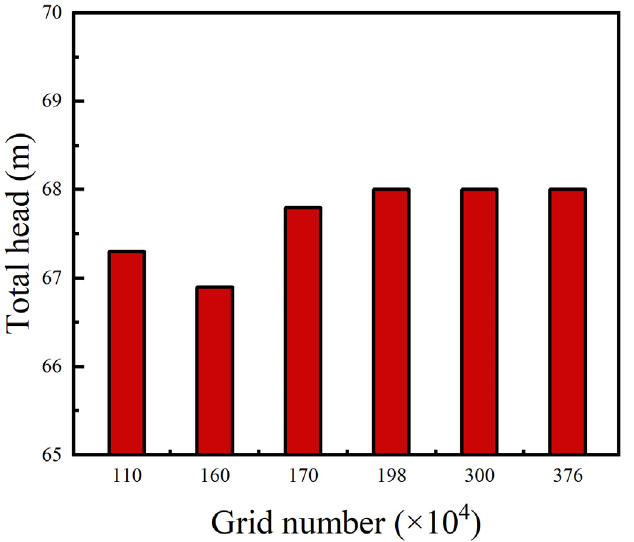
Fig. 5. Mesh grids independence analysis.